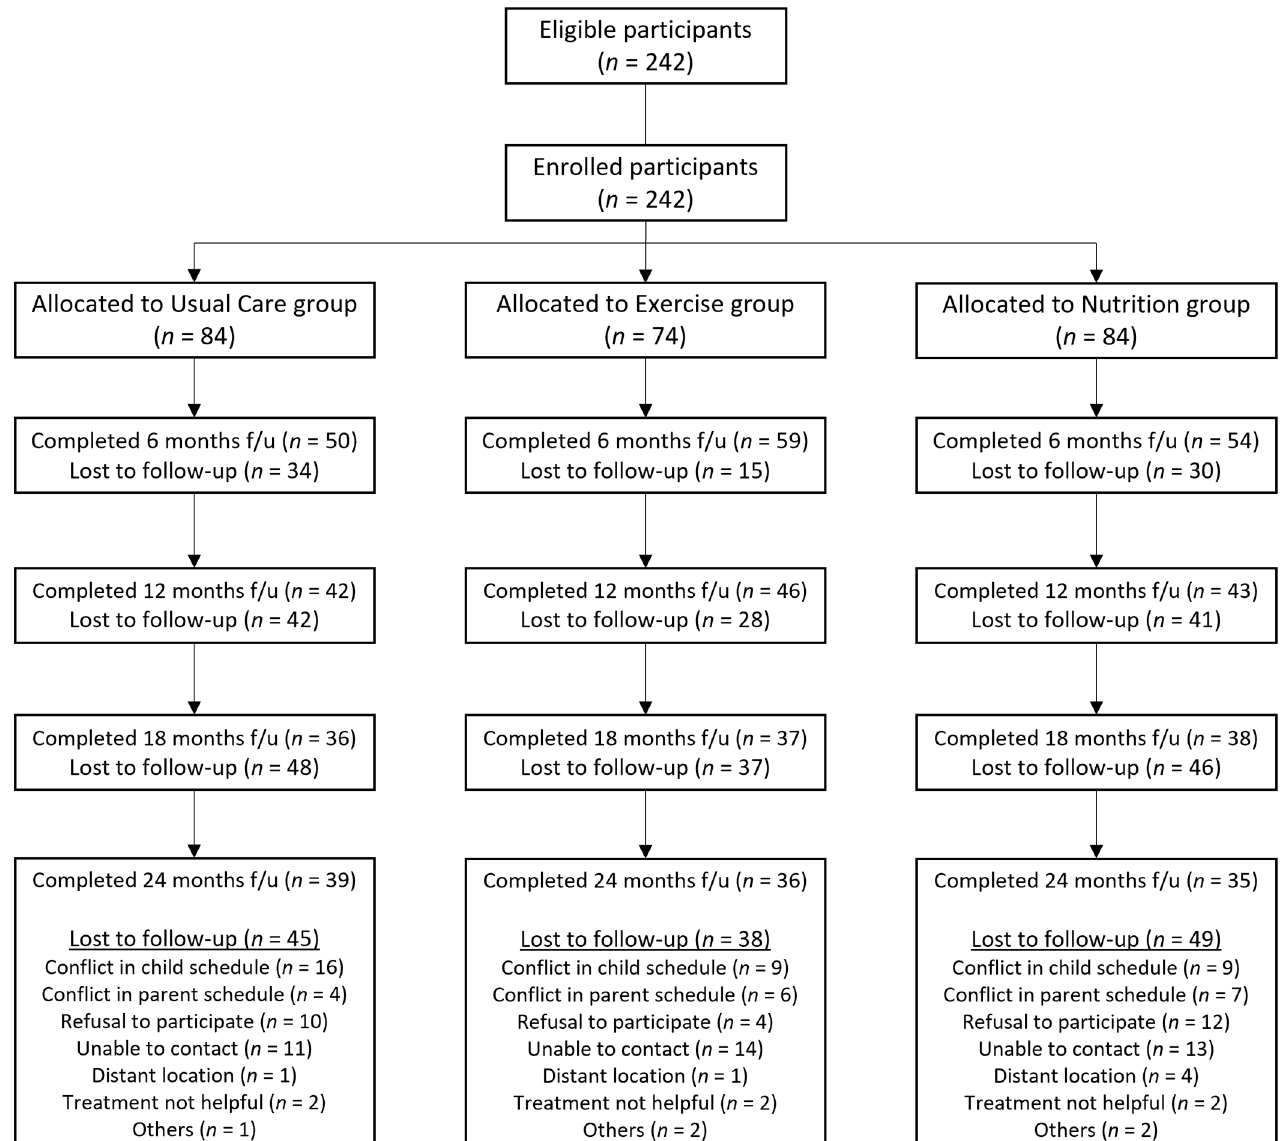
Figure 1. Flowchart of participant allocation.